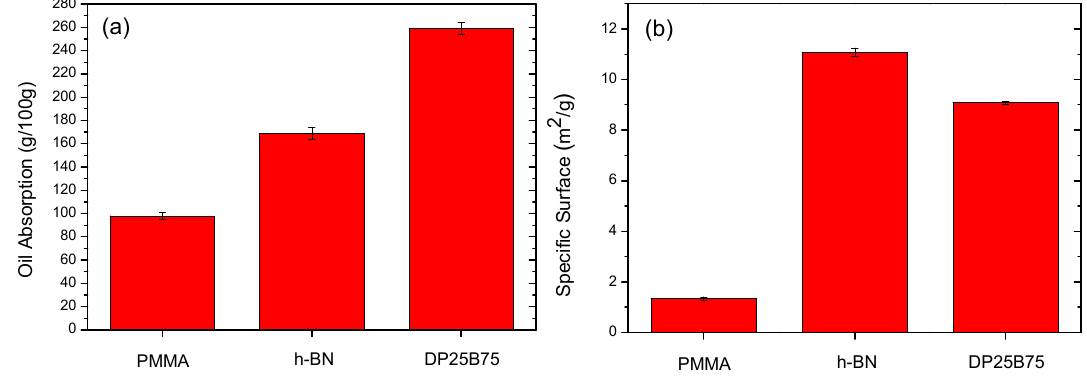
Figure 4. ( a ) Oil absorption and ( b ) specific surface area of PMMA, h-BN, and DP25B75